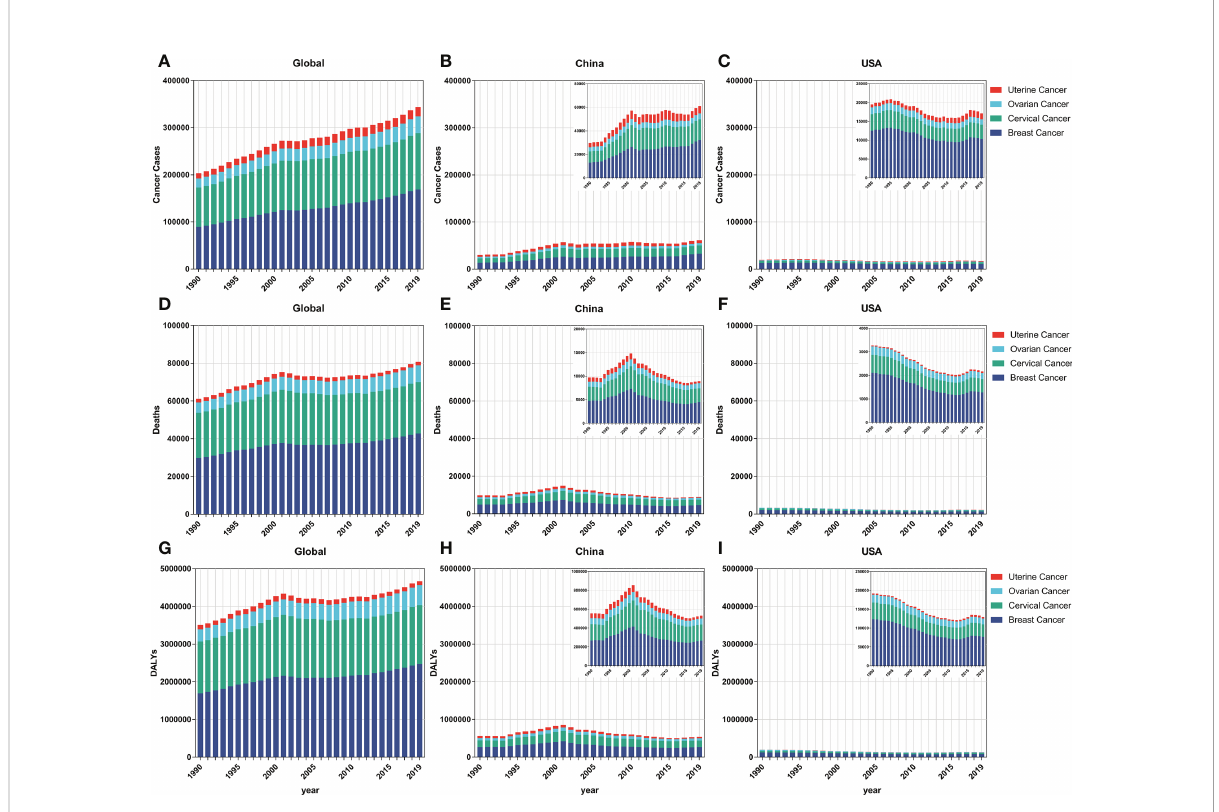
FIGURE 1 The incidence cases, mortality cases, and DALYs of FeBGCs among AYAs from 1990 to 2019. (A – C) The incidence cases of female breast and gynecologic cancers among AYAs in the globe, China, and USA. (D – F) The mortality cases of female breast and gynecologic cancers among AYAs in the globe, China, and USA. AYAs, adolescents and young adults; USA, the United States of America. (G – I) The DALYs of female breast and gynecologic cancers among AYAs in the globe, China, and USA. AYAs, adolescents, and young adults; DALYs, disability-adjusted life years; FeBGCs, female breast and gynecologic cancers; USA, the United States of